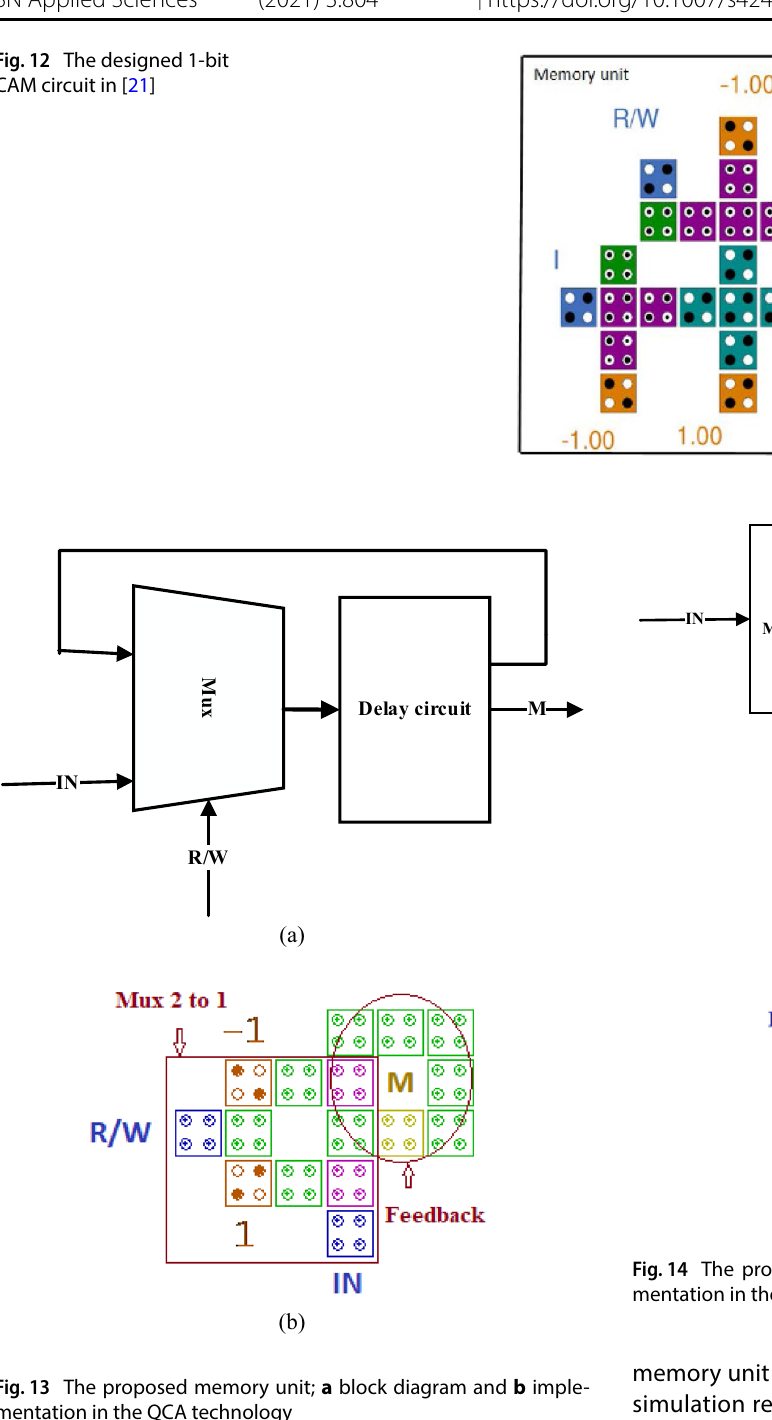
Fig. 12 The designed 1-bit CAM circuit in [21]